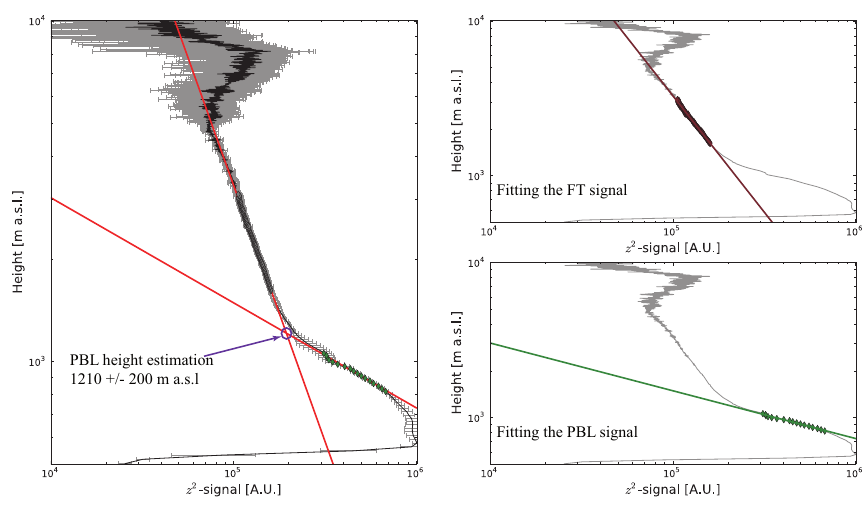
Fig. 2. Method for estimating the PBL, FT and interface layer limits. On the three graphical views, the mean z 2 -signal profil during the nucleation event is represented. On the right hand side, fitting of the Rayleigh diffusion dominated regime (upper panel) and the Mie diffusion dominated regime (lower panel) are represented. The complete procedure with the PBL height estimation is represented on left hand side panel.